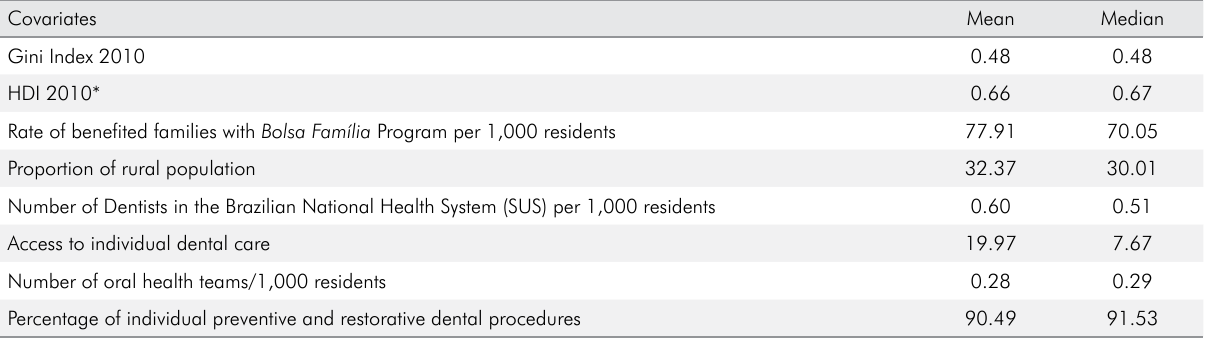
Table 2. Socioeconomic and oral health service characteristics of the 421 municipalities that have dispensed systemic antibiotics prescribed by dentists, SIGAF, 2017.